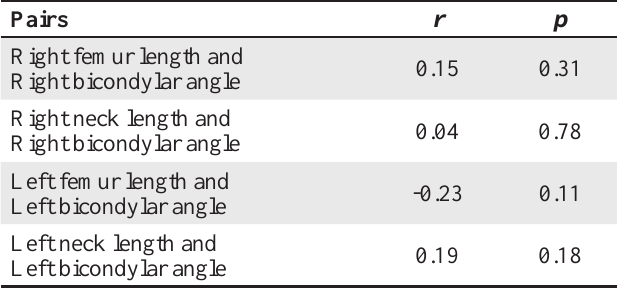
Table 2 : Pearson correlations between bicondylar angle and other femur parameters Pairs r p Right femur length and Right bicondylar angle Right neck length and Right bicondylar angle